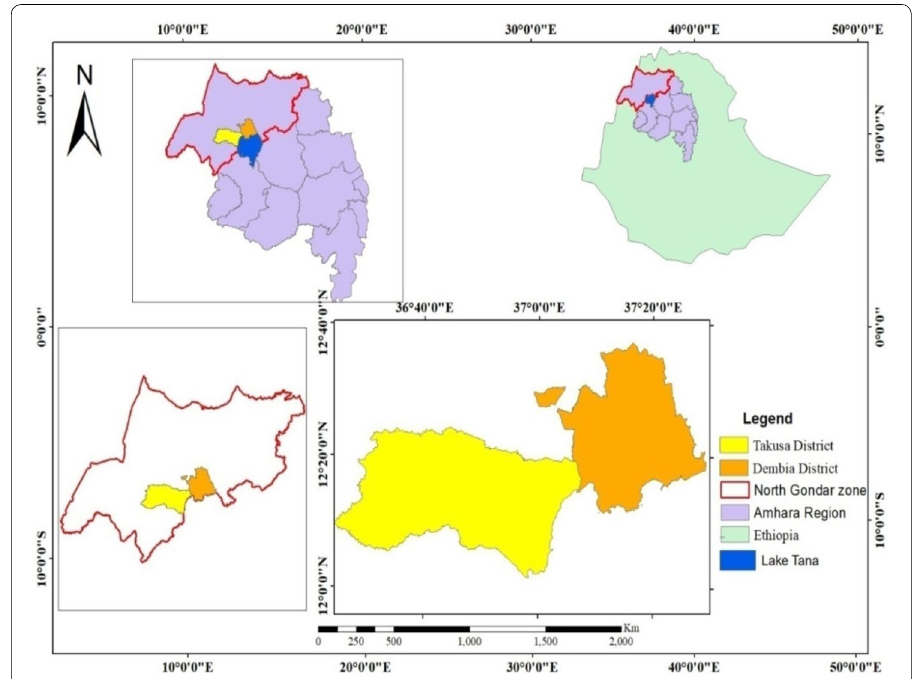
Fig. 2 Map of study area (source: Abate et al. (2019) and Dessie et al.